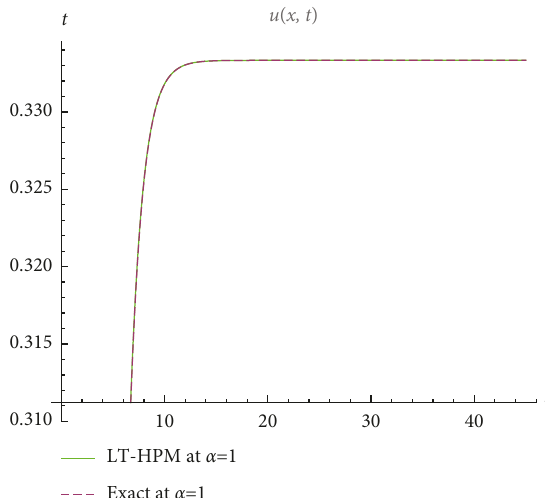
Figure 2: Error distribution between the approximate solution and the exact solution at α